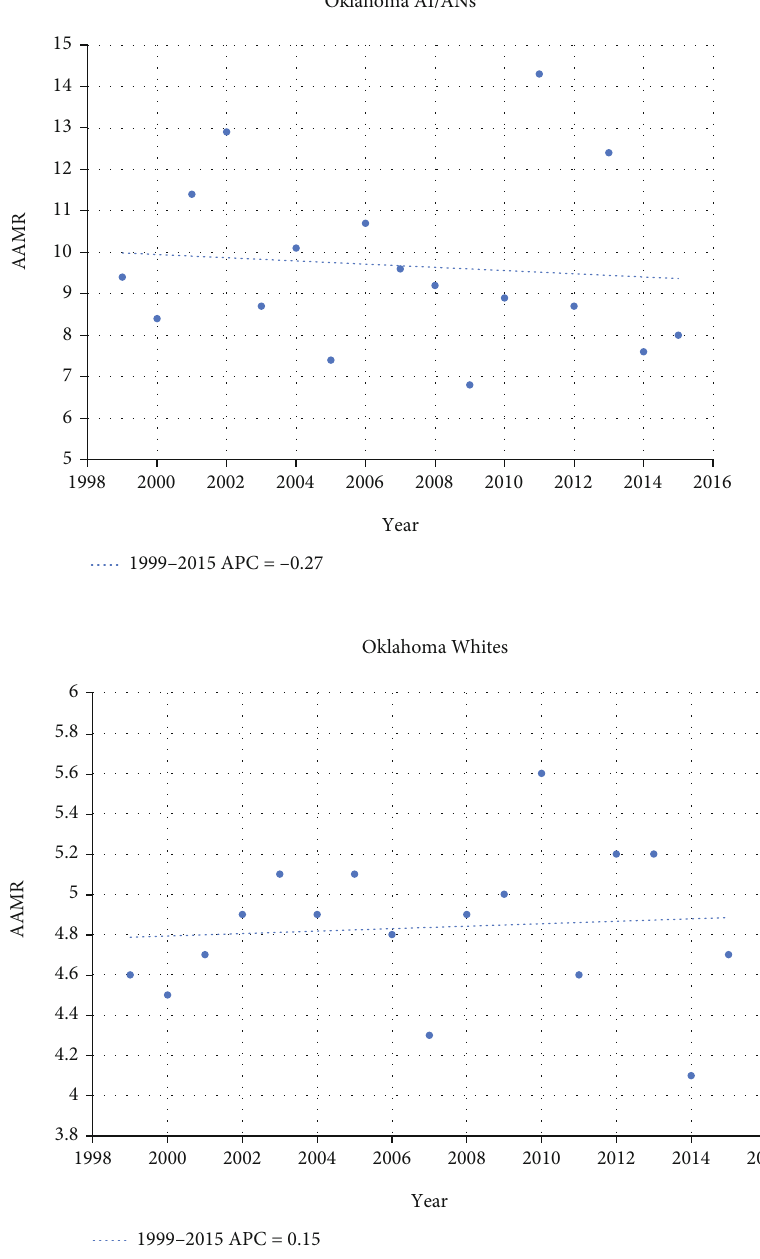
Figure 3: Joinpoint regression comparing AAMR between Oklahoma AI/ANs and Whites over time (rates per 100,000 population). ∗ Indicates that the annual percentage change (APC) is signi fi cantly di ff erent from zero at the alpha = 0 : 05